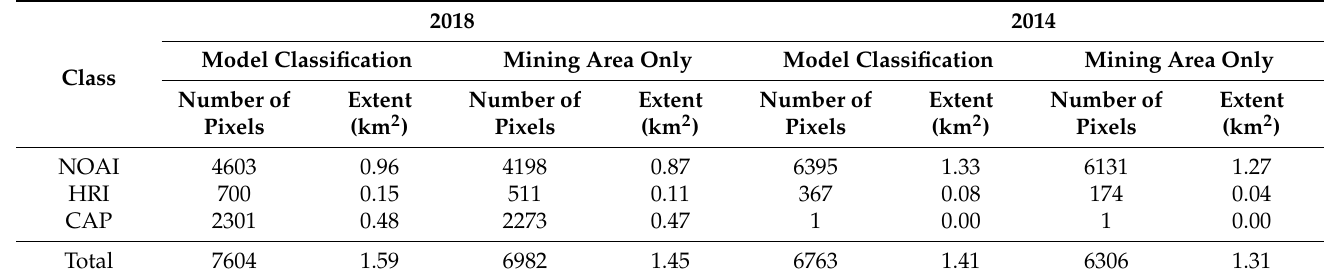
Table 8. Spatial assessments of NOAI, HRI, and CAP BLR model applications in both 2018 and 2014 AVIRIS data. The calculation of the mining area only is made inside Jefferson Lake’s open pit mining